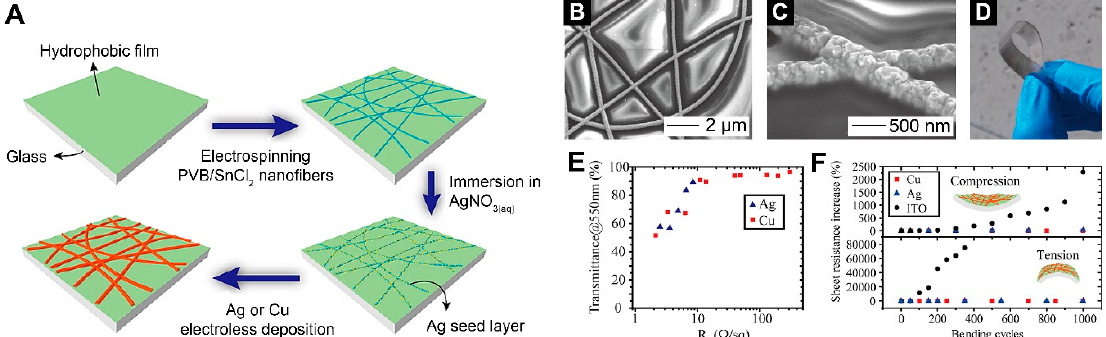
Figure 4. ( A ) Synthesis scheme for 2D transparent metal nano-networks fabricated with electrospun fiber templates (based on polyvinyl butyral (PVB)), which are selectively seeded and metallized with electroless plating. ( B ) SEM image of a Cu nano-network. ( C ) SEM detail image of a junction in a Ag nano-network. ( D ) Photograph of a Cu nano-network electrode deposited on a flexible poly(ethylene terephthalate) substrate. ( E ) Transmittance of Ag and Cu nano-networks of varying areal nanowire density, showing the trade-off between conductivity and transparency. ( F ) Change of the nano-network sheet resistance during repeated bending, showing excellent durability as compared to the brittle ITO. Reprinted (adapted) with permission from [46]. Copyright (2014) American Chemical Society.